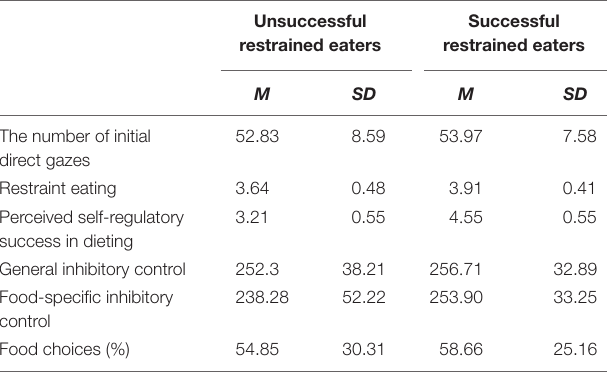
TABLE 1 | Means and standard deviations on the measures of the main variables for the unsuccessful and successful restrained